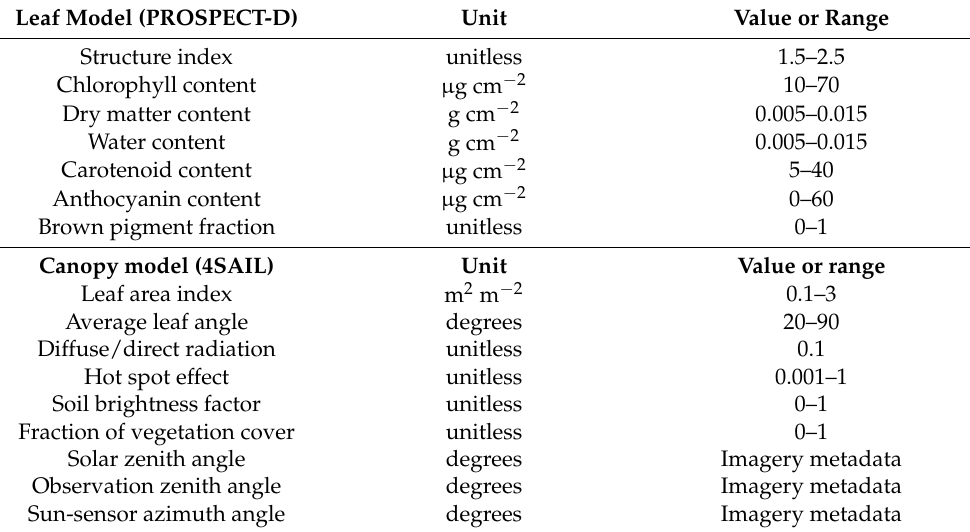
Table 1. Value or range of input variables for PROSPECT-D and 4SAIL